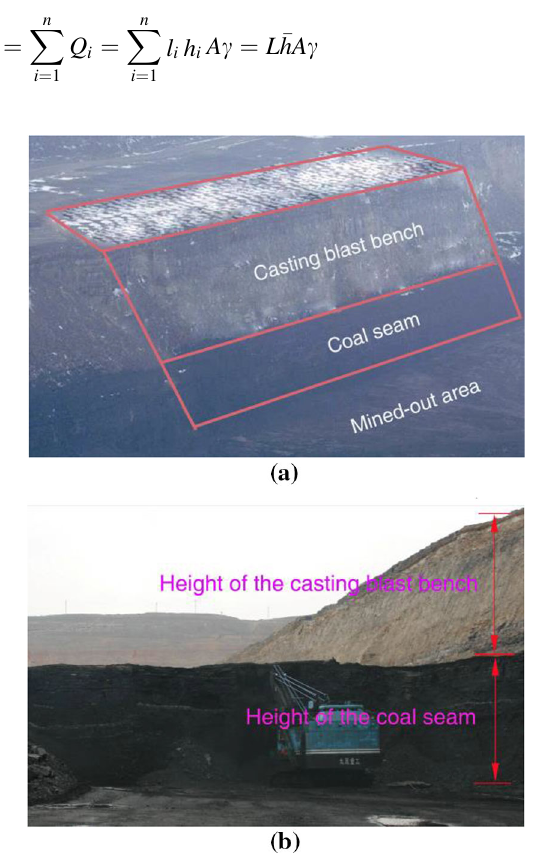
Fig. 1 Photograph of blast casting bench and coal